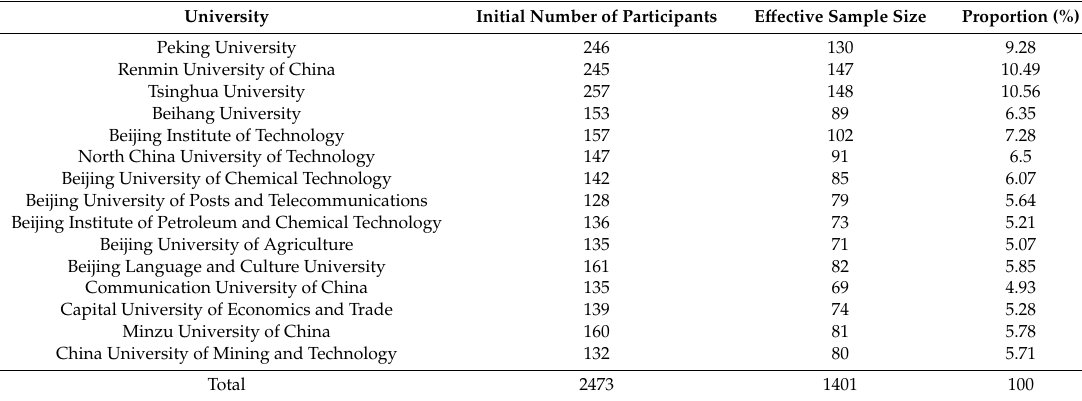
Table 1. Sample sizes of di ff erent universities.